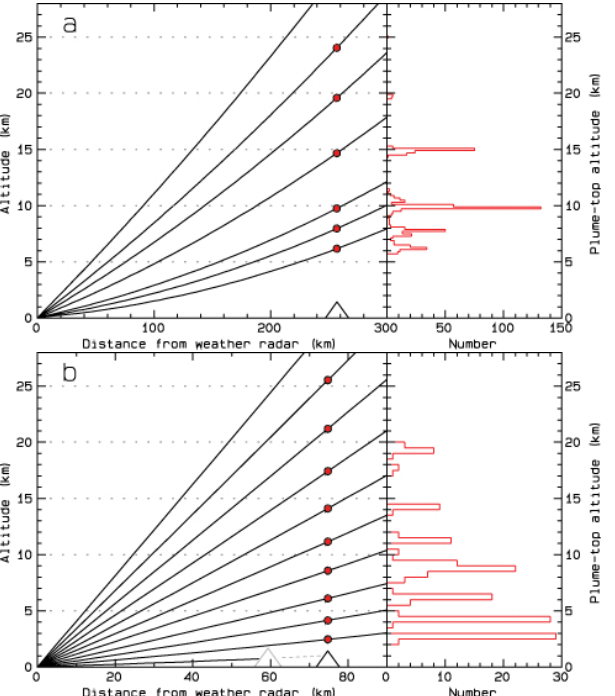
Figure 2. Left: a range-height diagram of the altitude (kma.s.l.) as a function of distance from the weather radars (km), for the low- est elevation angles of the scanning strategy during the eruption. The location of Grímsvötn is marked with a black triangle. Right: a histogram of the plume-top altitudes (kma.s.l.) observed by the radars. (a) Range-height diagram and histogram of altitude esti- mates from the C-band Keflavík weather radar. The seven lowest elevation angles (0.5–6.0 ◦ ) are shown. (b) Range-height diagram and histogram of altitude estimates from the X-band mobile weather radar located close to Kirkjubæjarklaustur. The eleven lowest ele- vation angles (0.5–23.8 ◦ ) are shown. Note that the lowest elevation angle is blocked by the Þórðarhyrna mountain, marked by a gray triangle.